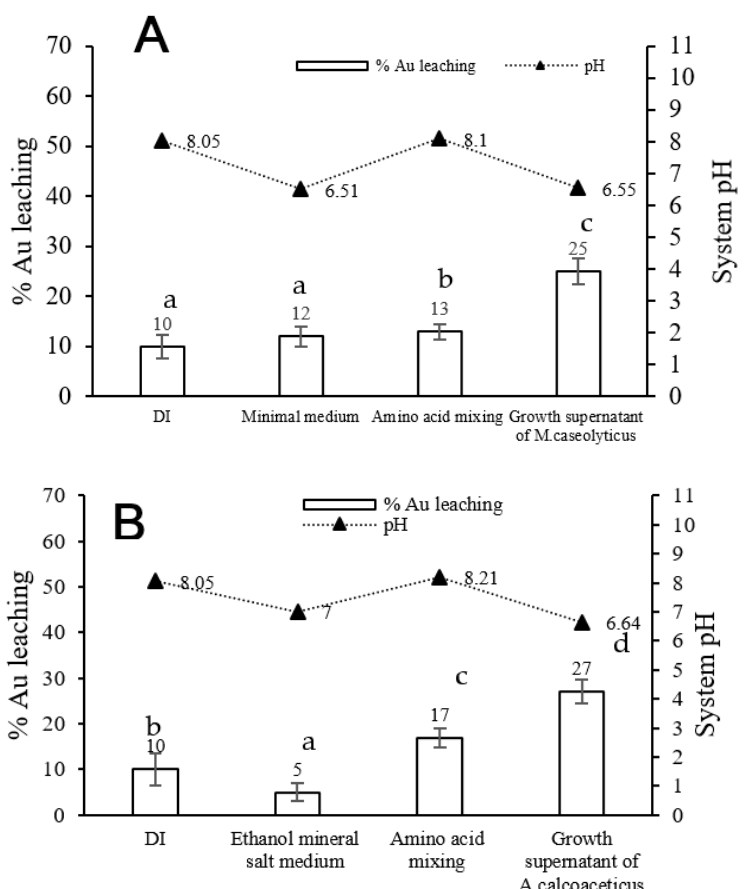
Figure 6. Comparison of gold bioleaching efficiency by growth supernatant of isolated strains ( A ) M. caseolyticus and ( B ) A. calcoaceticus with amino acid mixing (at the same concentration with growth supernatant) within 15 days. The flasks were shaken at 150 rpm, 30 °C, and the particle size of ores was approximately ≤ 75 µm. Data were expressed as the mean ± SD ( n = 3) and analyzed by Duncan’s test ( p < 0.005). The lower case letters compared the percentage of gold bioleaching by control (DI water), medi-um, amino acid mixing and growth supernatant by ( A ) M. caseolyticus and ( B ) A. calcoaceticus